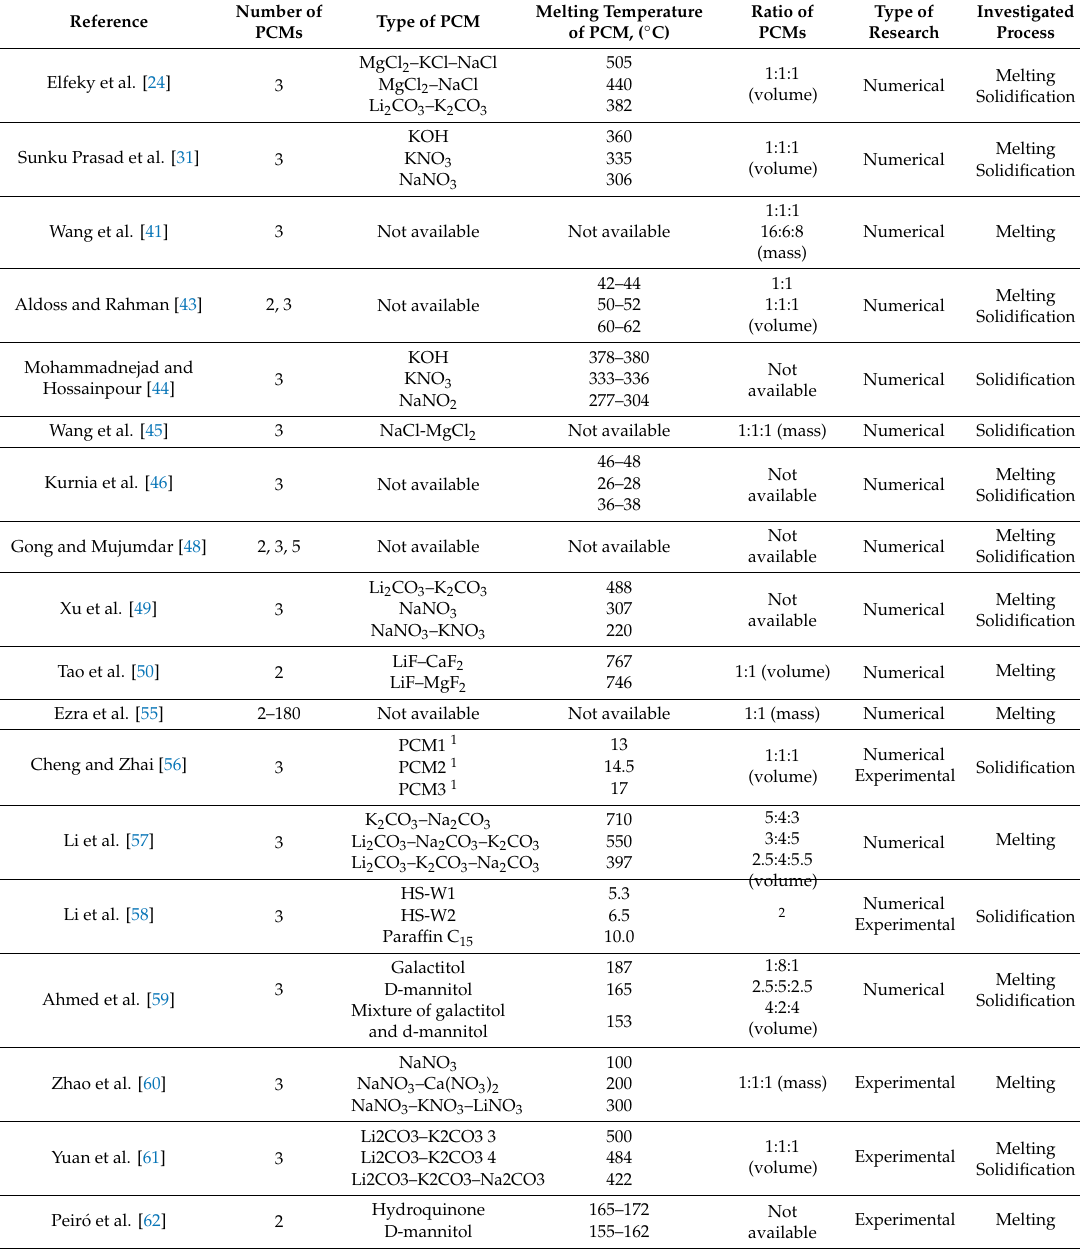
Table 1. Research on heat transfer enhancement with multiple